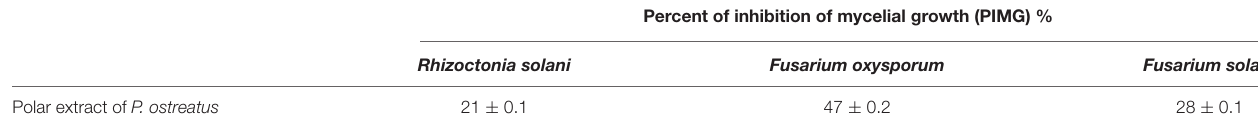
TABLE 3 | Antifungal effect of Pleurotus ostreatus fruiting body polar extract (PoPE).